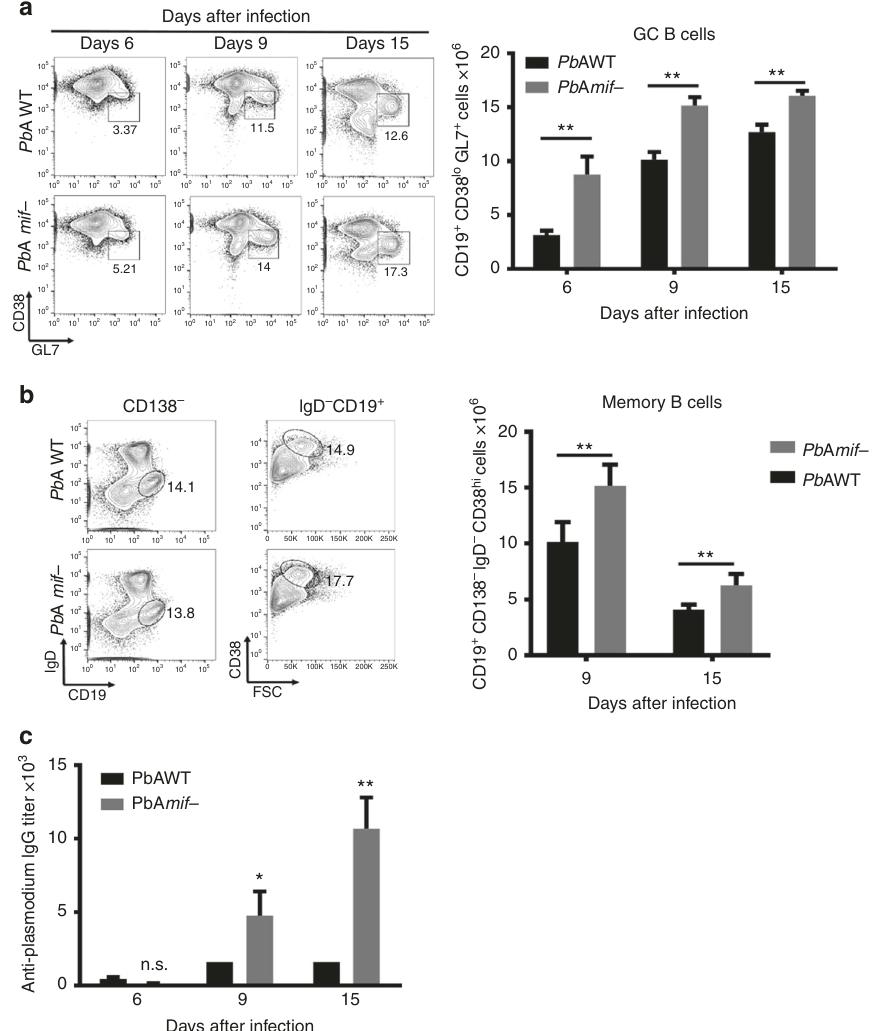
Fig. 1 PMIF impairs germinal center formation. BALB/cJ mice were infected with 10 6 Pb AWT or Pb A mif − iRBCs. On day 6, 9, and 15, splenocytes were isolated and the total number of a germinal center (CD19 + CD38 lo GL7 + ) and b (CD19 + CD138 − IgD − CD38 hi ) memory B cells were determined. Results are from three separate experiments. Bars represent the mean of 12 mice ± SD. ** p < 0.05 by Mann – Whitney test. c Anti- Plasmodium antibodies titers from BALB/cJ mice that were infected with Pb AWT or Pb A mif − iRBCs. On day 6, 9, and 15, sera of infected mice were collected, and the Plasmodium -speci fi c IgG responses measured by ELISA. Results are from three separate experiments. Bars represent the mean of 12 mice ± SD; n.s.: p > 0.05; * p < 0.05; ** p < 0.01 by two-way